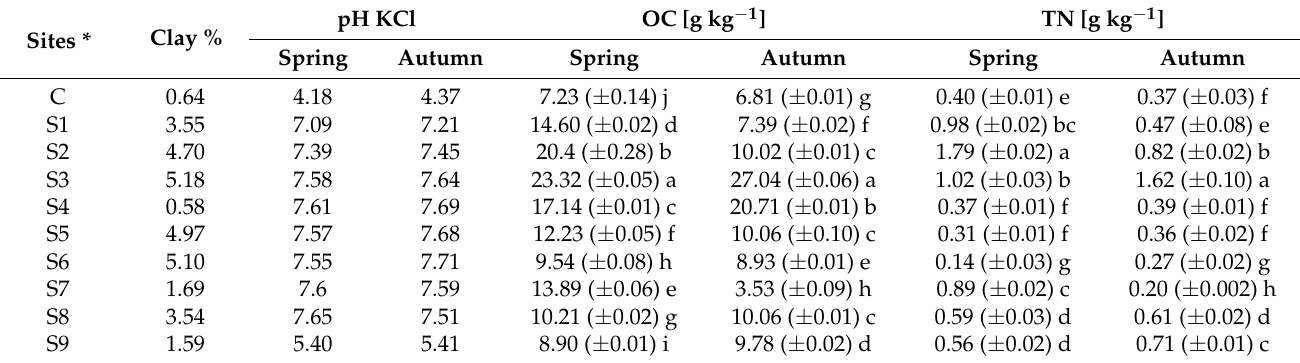
Table 1. Content of clay fraction, pH in KCl and organic carbon (OC) and total nitrogen (TN) in soil.